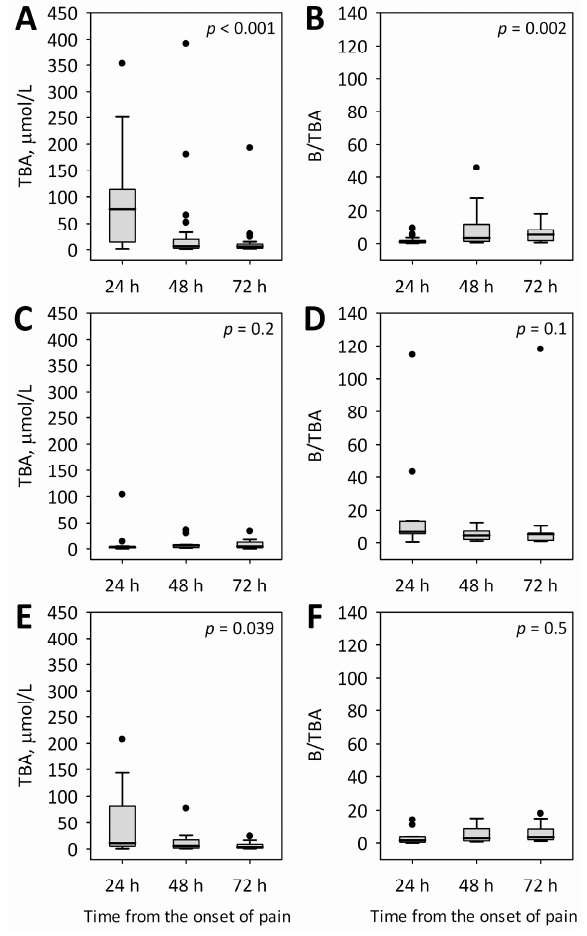
Figure 1. Changes in TBA serum concentrations and B/TBA ratios in patients with acute pancreatitis of biliary ( A , B ); alcoholic ( C , D ); and other ( E , F ) etiologies during the first 72 h of the disease. Data are shown as median, interquartile range (box), non-outlier range (whiskers), and outliers (dots); p -values for the difference between the time points are shown on the graphs.